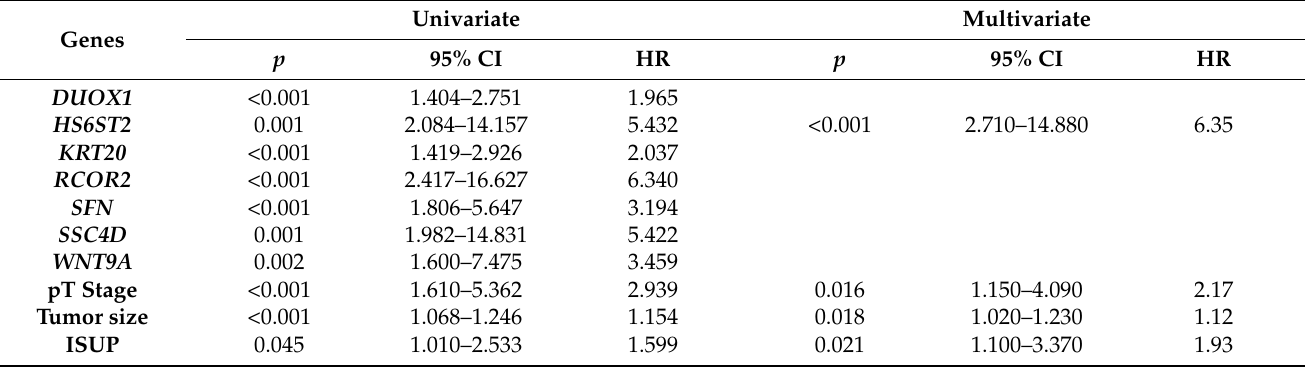
Figure 1. Differentially expressed genes in the discovery phase. ( A ) Heat map displaying the 50 most DEGs between progressive and non-progressive intermediate/high-risk ccRCC patients. Red pixels correspond to up-regulated genes, whereas green pixels indicate down-regulated genes. ( B ) GSEA shows positive correlation of DEGs in pathways involved in tumor progression. Abbreviations: DEGs, Differentially expressed genes. GSEA, Gene set enrichment analysis. Table 2. Univariate and multivariate Cox regression analysis of statistically significant genetic and clinical variables in the validation